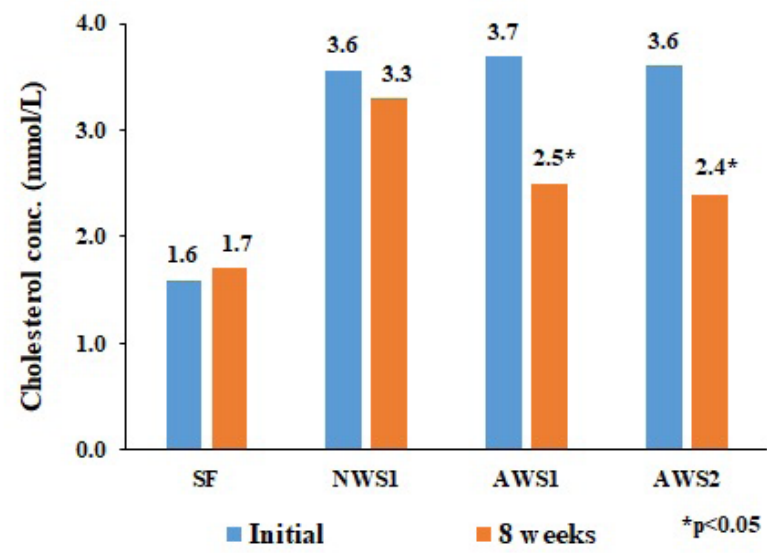
FIGURE 5 - Cholesterol concentrations of four experimental mice groups after 8 weeks.